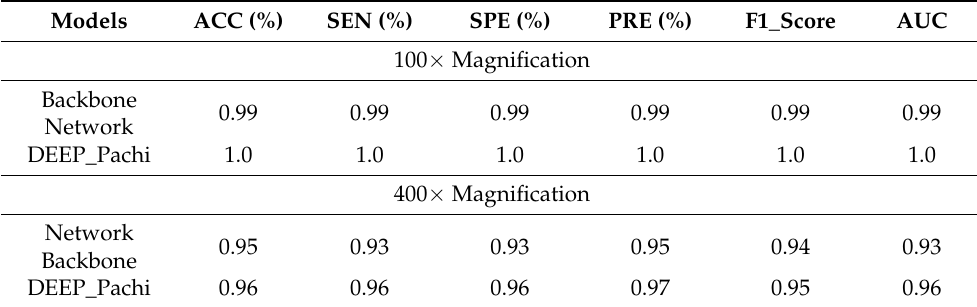
Table 8. Binary classification using